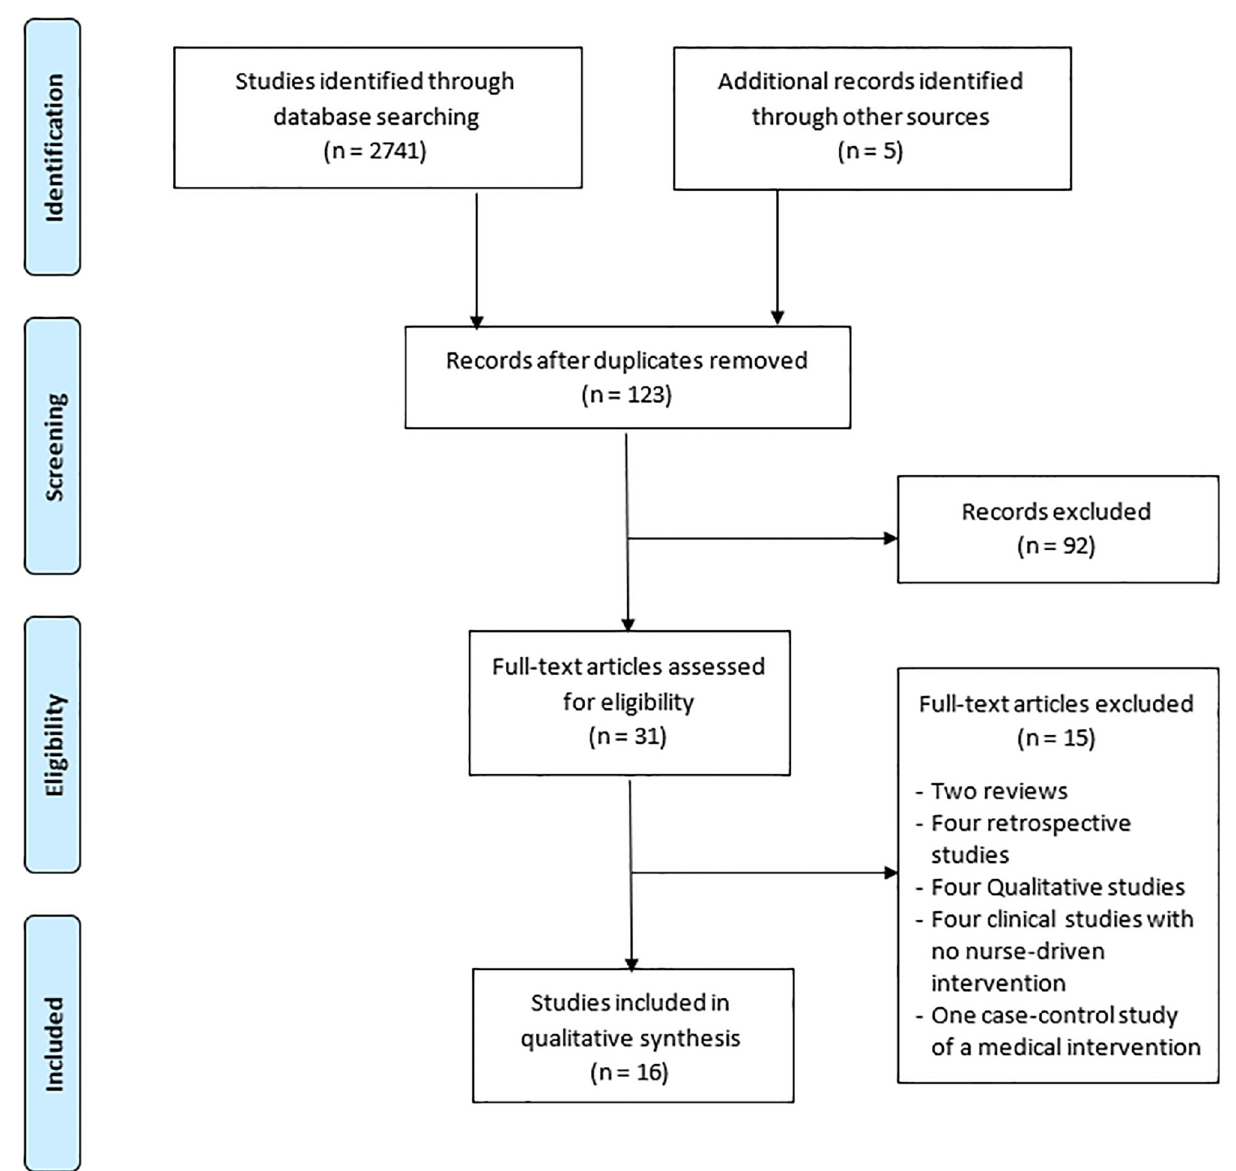
Fig 1. Prisma flow